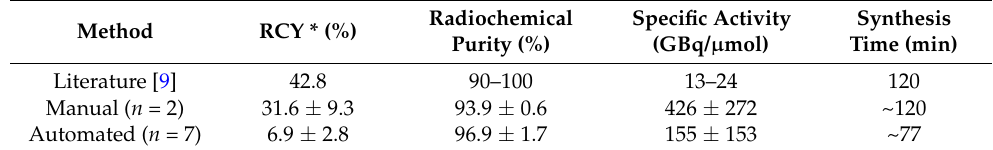
Table 2. Comparison of three methods for radiosynthesis of [ 18 F]DHMT.